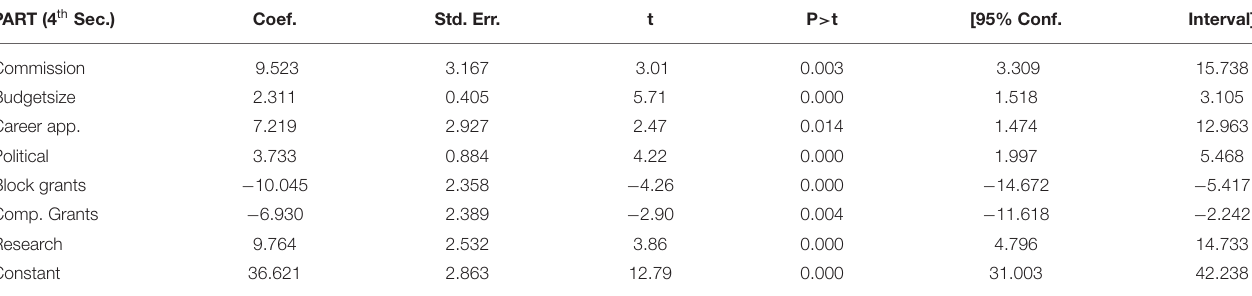
TABLE 8D | Model for accountability/results section of PART. PART (4 th